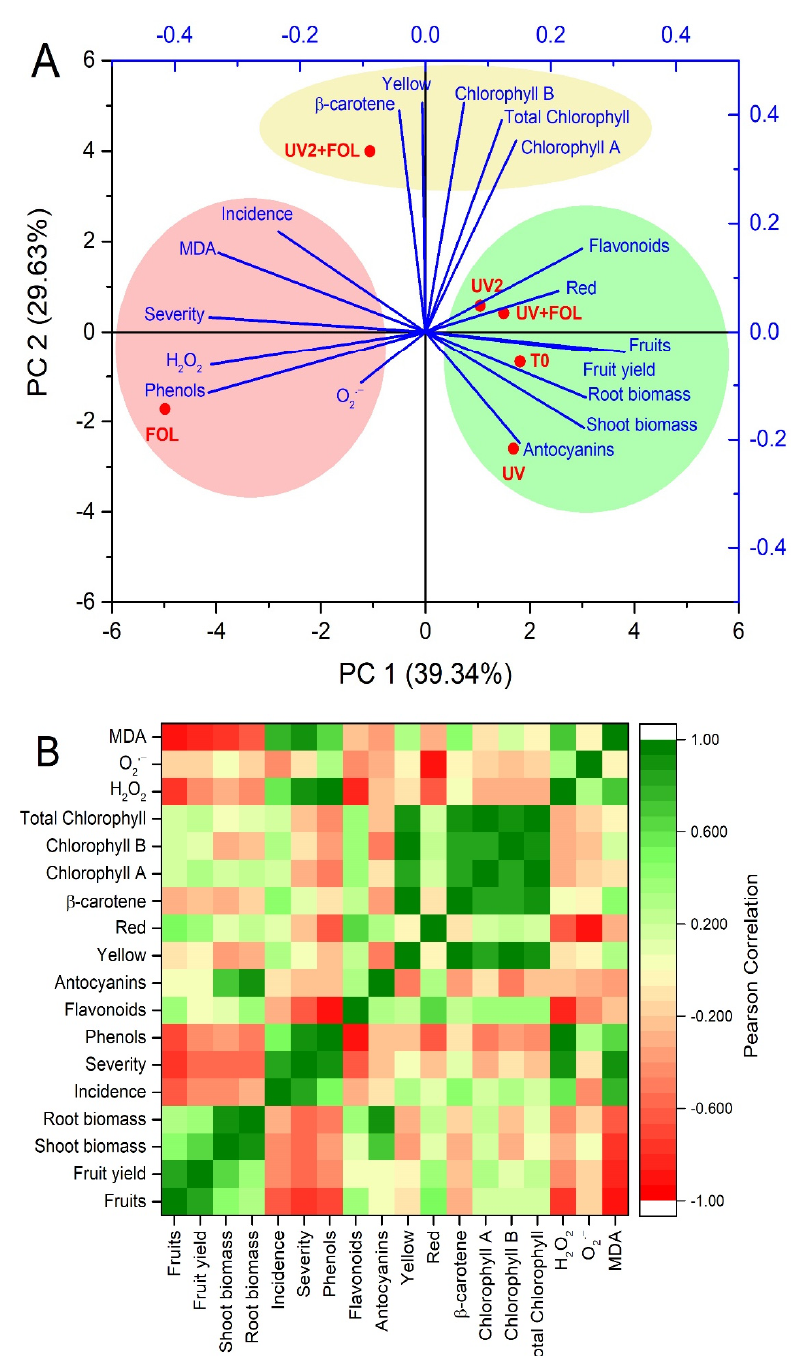
Figure 7. Biplot of the treatments and response variables ( A ), and Pearson correlations of the response variables ( B ) of tomato plants inoculated with Fol and supplemented with UV-A radiation. T0, negative control (tomato plants without UV-A radiation and without Fol inoculation); FOL, positive control (tomato plants only inoculated with Fol); UV, tomato plants supplemented with UV-A radiation through one LED lamp; UV + FOL, tomato plants supplemented with UV-A radiation through one LED lamp and inoculated with Fol; UV2, tomato plants supplemented with UV-A radiation through one LED lamp above the plant canopy plus one fixed lamp at the bottom of the plants; and UV2 + FOL, tomato plants inoculated with Fol and supplemented with UV-A radiation through one LED lamp above the plant canopy plus one fixed lamp at the bottom of the plants.